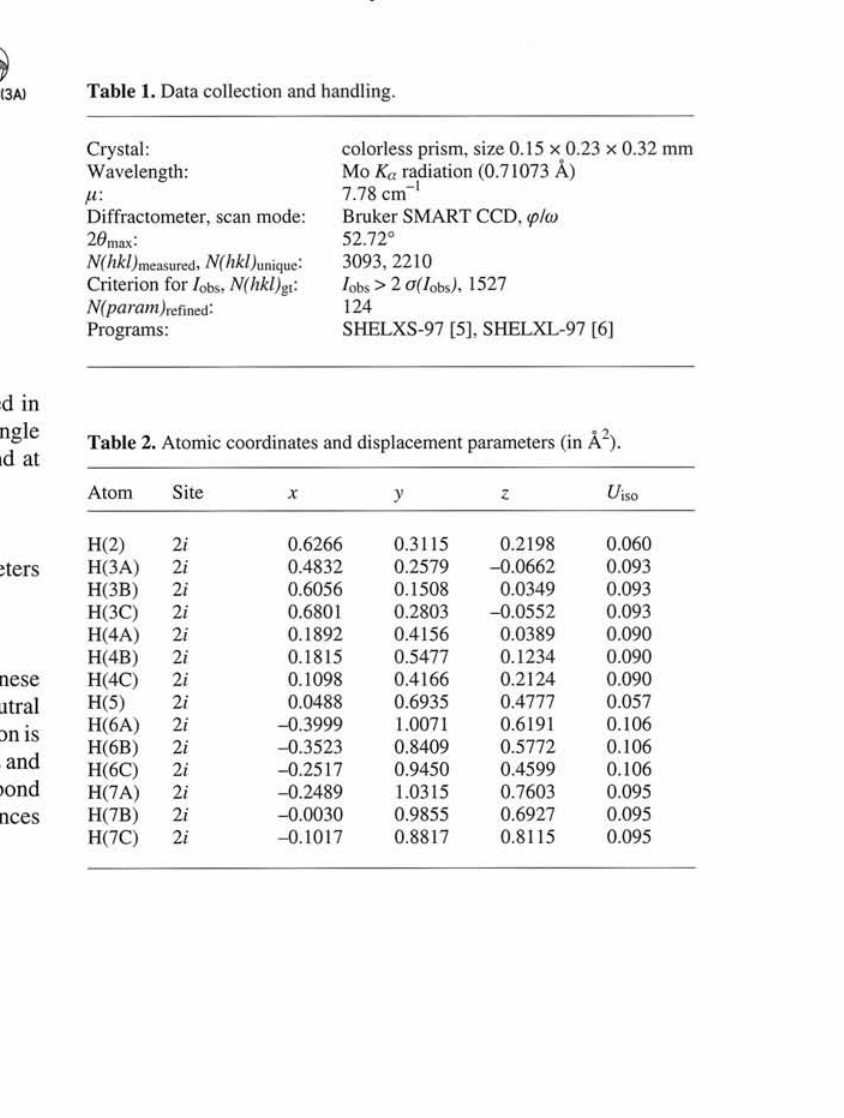
Table 1. Data collection and handling.